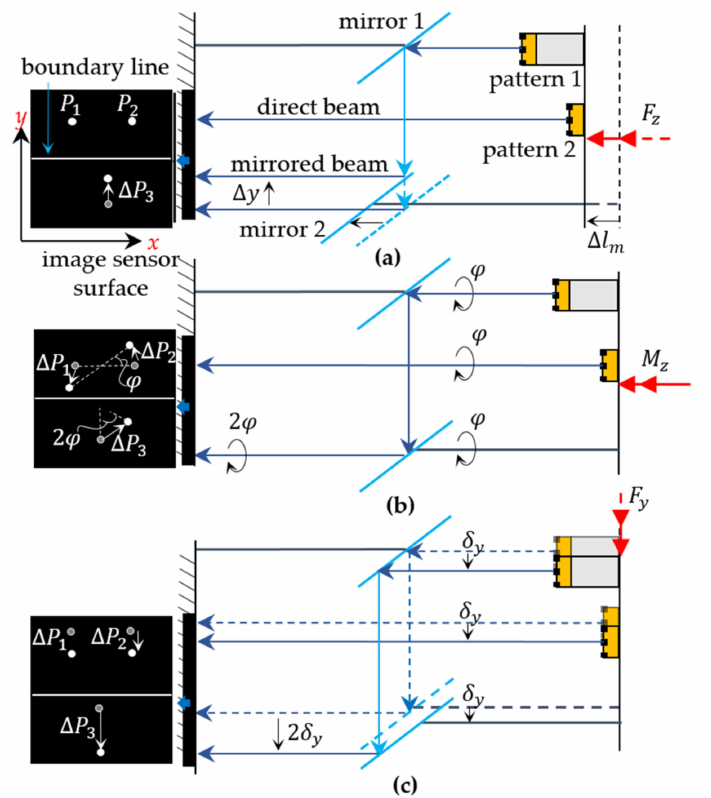
Figure 3. Visualization of the crosstalk behavior in the mirrored image segment by in-plane displace- ments. ( a ) compression ( b ) torsion ( c ) deflection.